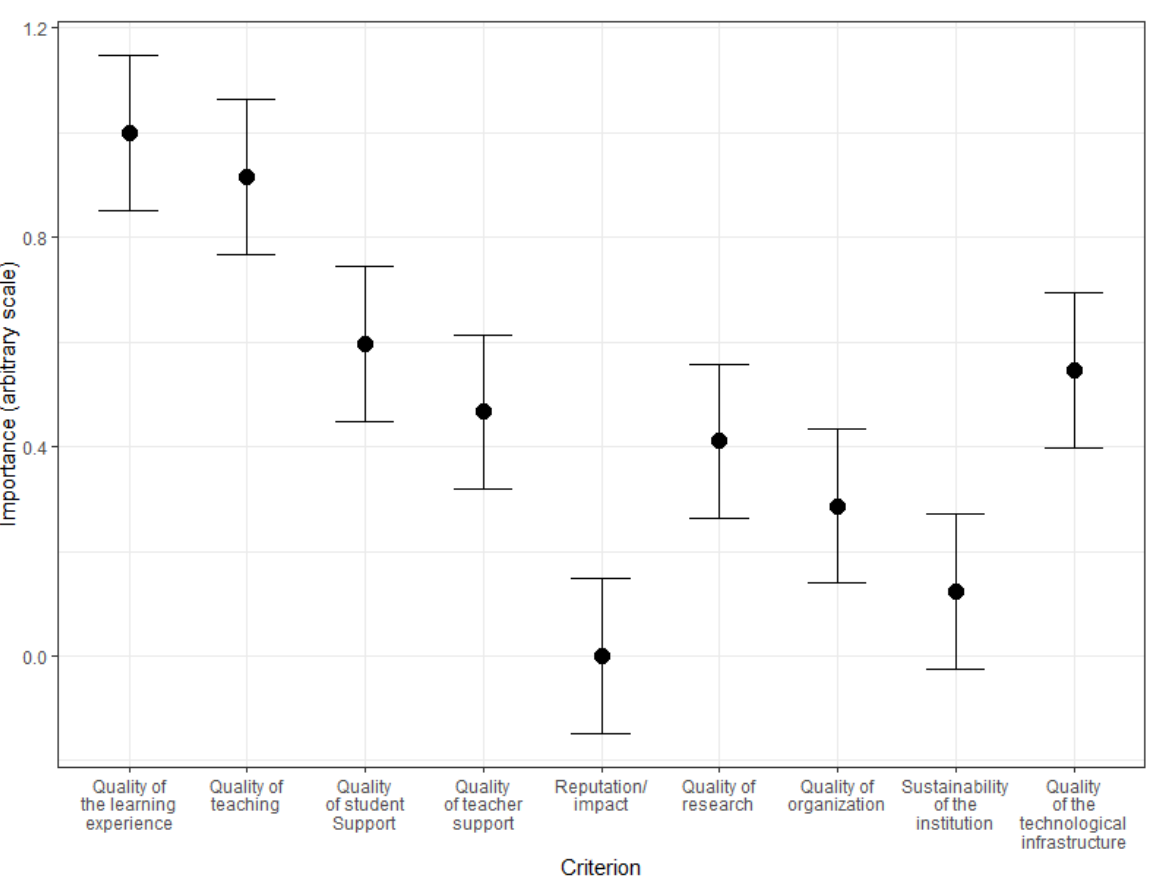
Figure 3 . Delphi Round 1 data analysis. Relative importance of criteria with 95% confidence intervals, as estimated by Thurstone Case V